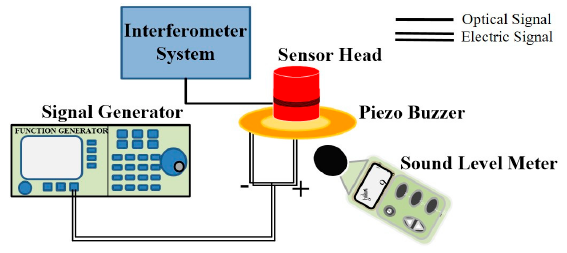
Figure 3. Experimental set-up for the calibration of the sensor.